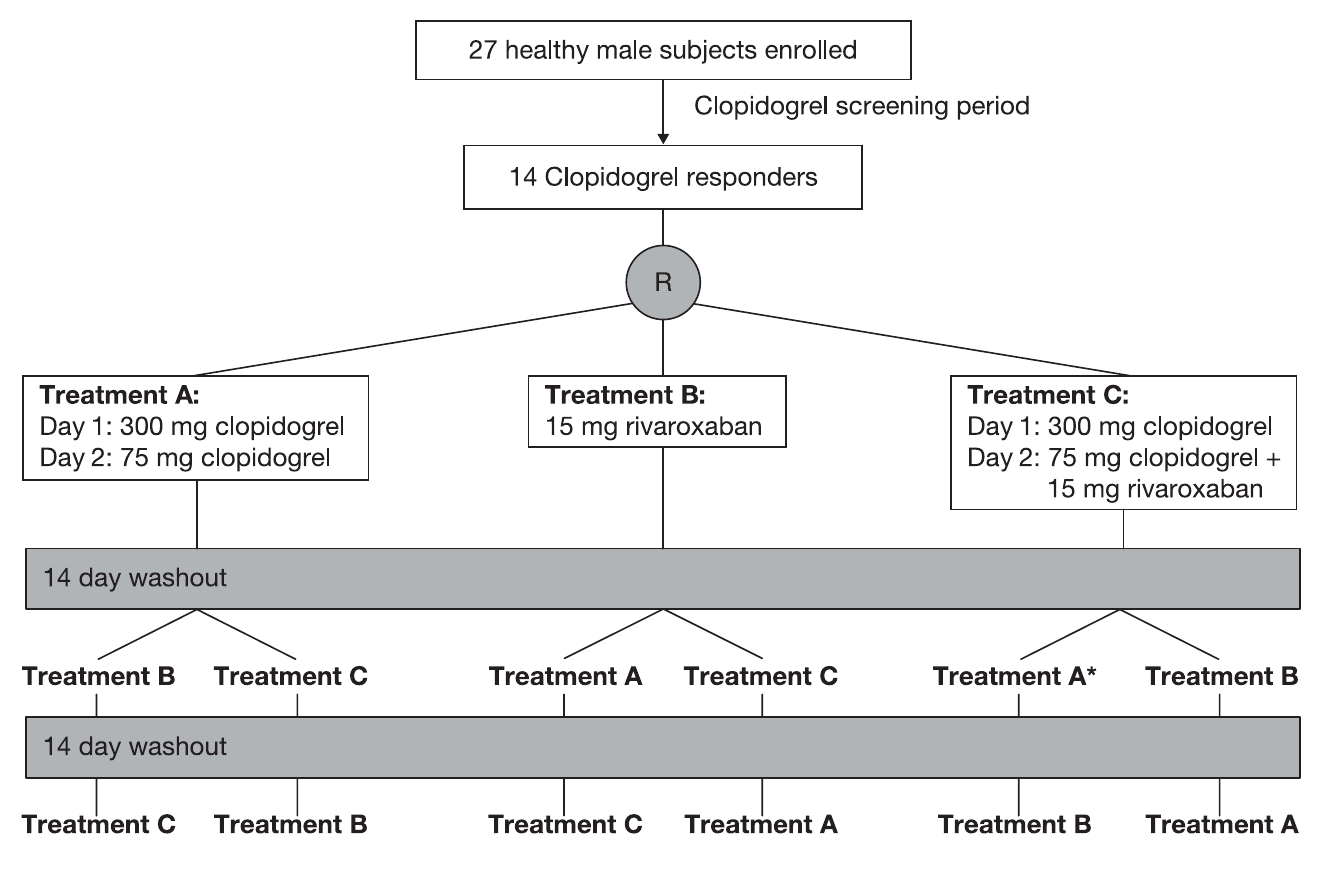
Figure 1. Study design of the three-way crossover study. * Treatment period during which one subject withdrew from the study owing to an adverse